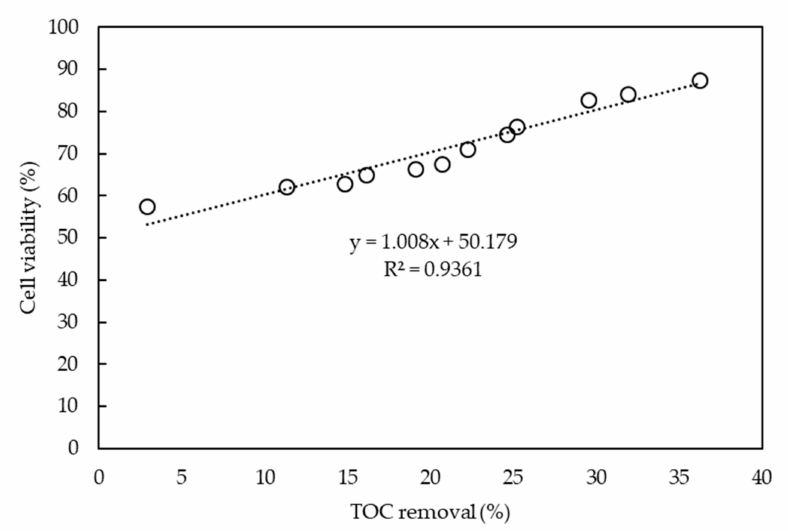
Figure 7. Correlation between cell viability and TOC removal in the tetracycline degradation